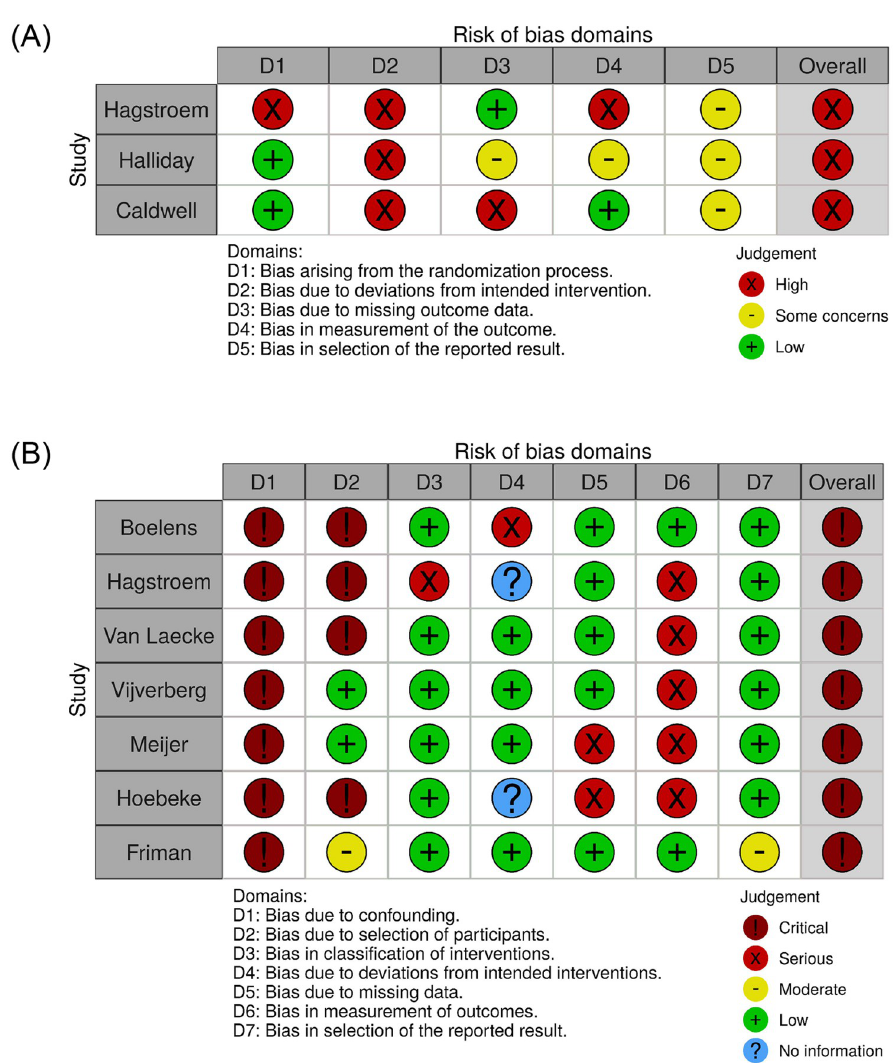
Fig 2. A. Risk of bias graph according to the Cochrane collaboration risk-of-bias RoB-2 tool for all included RCTs at an outcome level. B. Risk of bias graph according the National Heart, Lung and Blood Institute quality assessment tool for nonrandomized observational